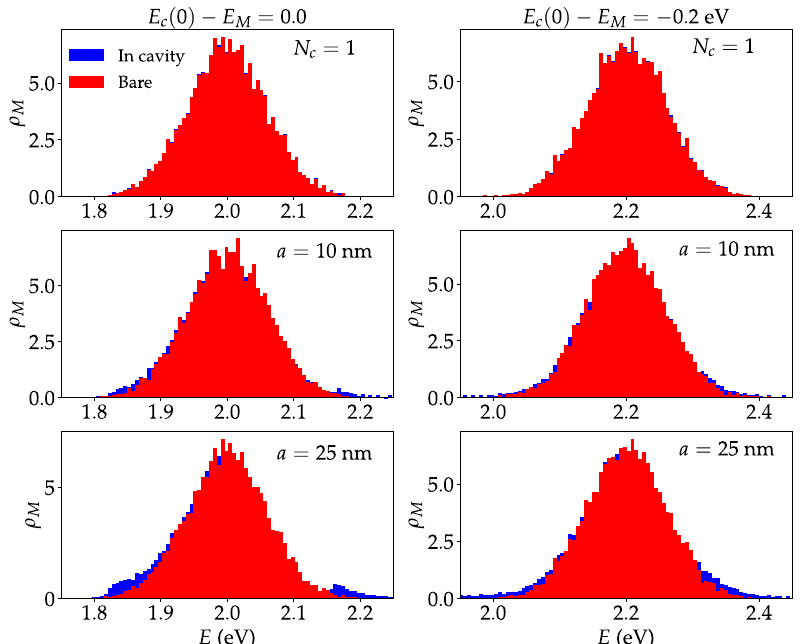
Fig. 8 Polariton effects on molecular LDOS of single and multimode cavities. Local molecular density of states for 10 realizations of a molecular system in free space (red) and under strong coupling (blue) to a photonic wire. N M = 1001, Ω R = 0.3 eV, σ / Ω R = 0.2, σ μ = 0.05 μ 0 , and f = 0.1 in all of the studied scenarios. In panels, where only a is speci fi ed, N C = N M . Note that larger single-molecule transition dipole moments are required to preserve Ω R when a is increased. This explains the stronger cavity effects on the molecular density of states when a = 25